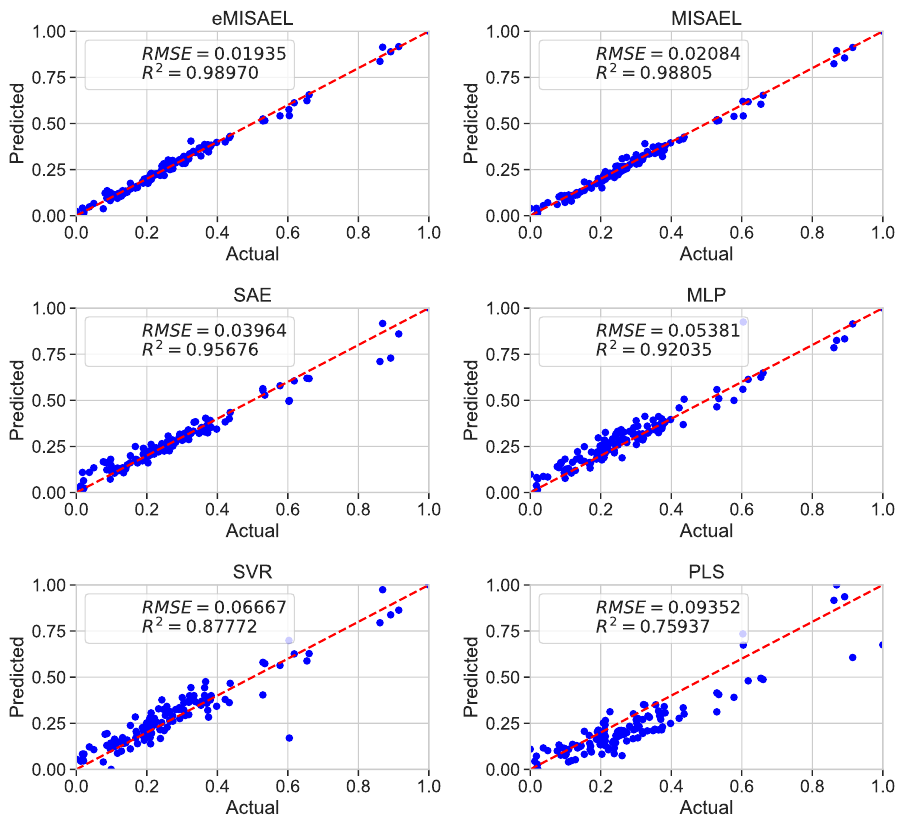
Figure 8. Real values of butane content and the predicted values using eMISAEL, MISAEL, SAE, MLP, SVR, and PLS soft-sensor models.